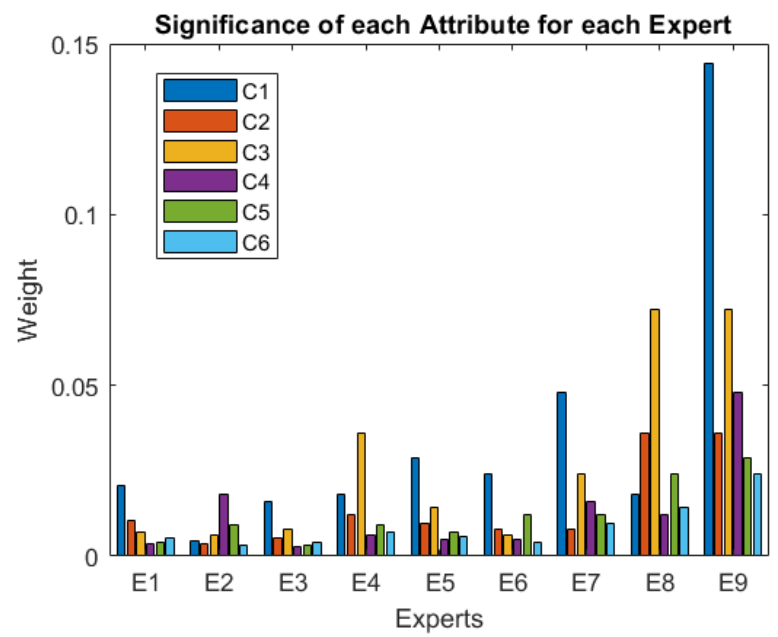
Figure 5. Significance of each attribute for each expert.